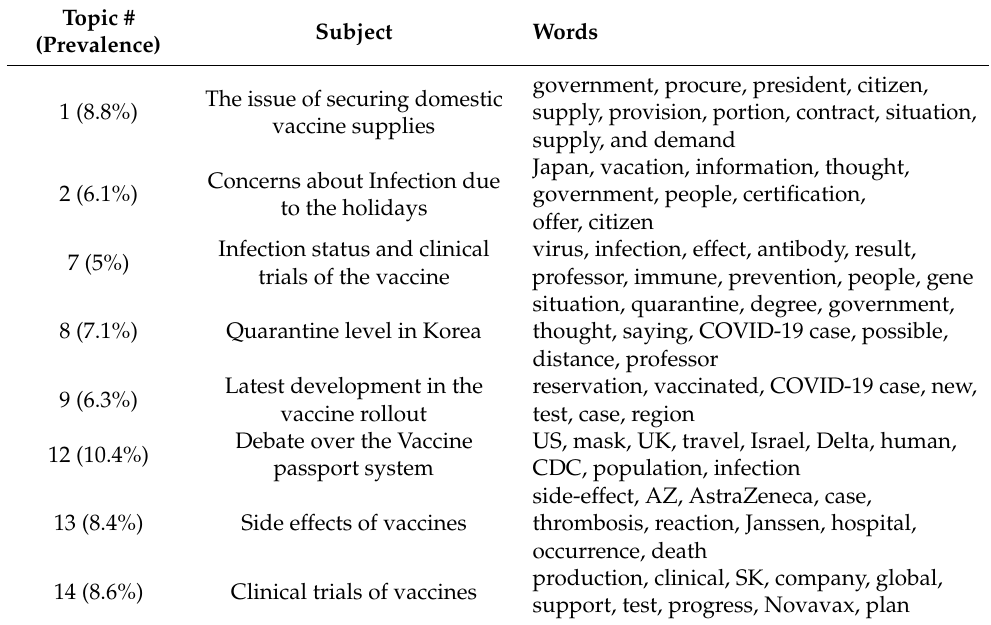
Table 5. Topics drawn from Phase 4 (1 April 2021–25 September